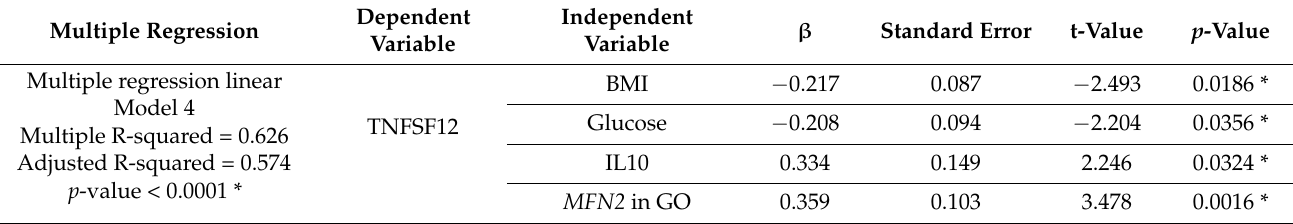
Table 4. Models of multiple regression analysis of the relationship between the sTNF-R1. TNFSF12 and TNFSF12 levels and glucose level, IL10 level, BMI, DNM1L gene expression in GO, MFN2 gene expression in GO, and TFAM gene expression in GO.